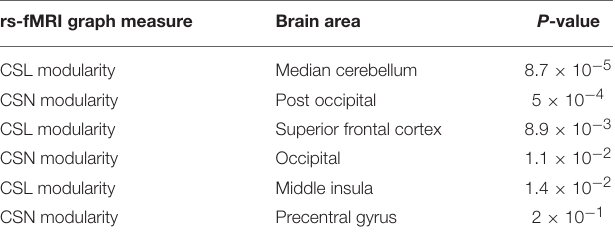
TABLE 4 | Top six features selected by the SFC algorithm for the four-group (AD, HC, MCI-C, and MCI-NC) classification.